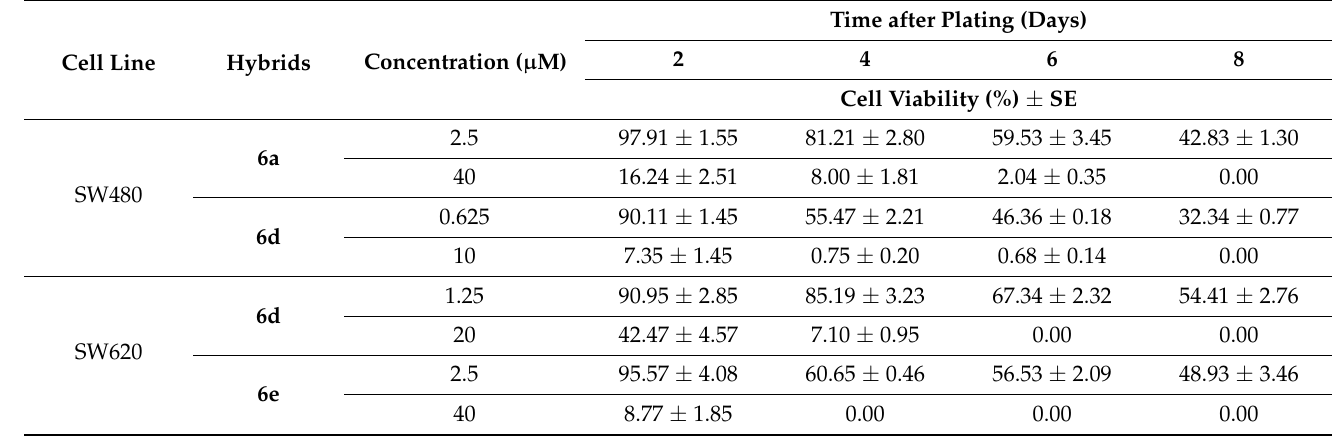
Table 3. Data of viability (%) at the lowest and the highest concentrations